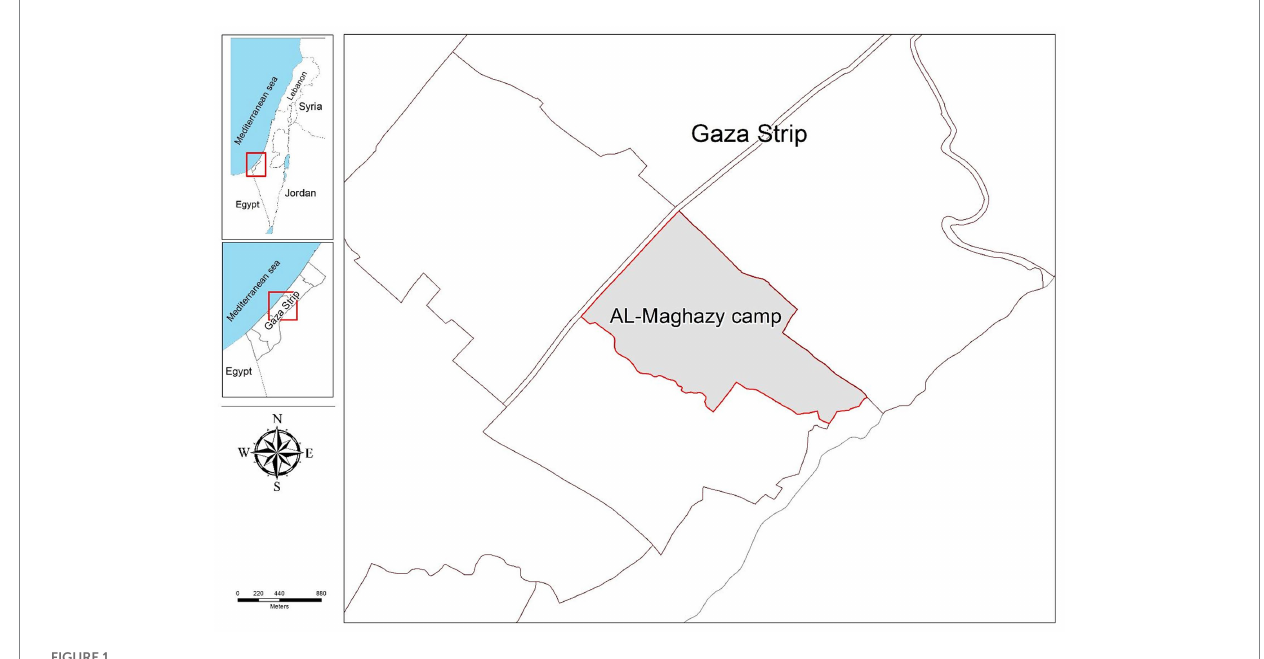
FIGURE 1 Map of the Al-Maghazi